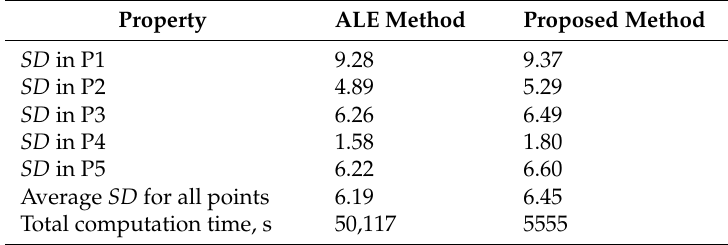
Table 2. Total computation time and standard deviation ( SD ) in di ff erent calculations at five